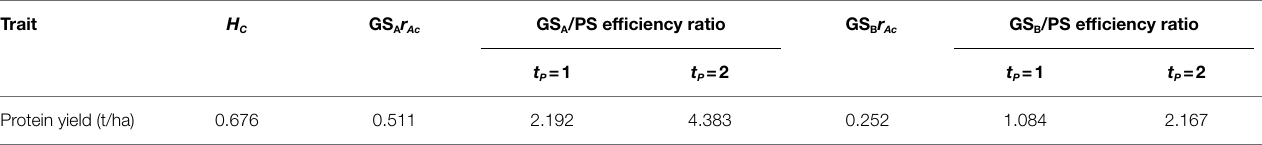
TABLE 9 | Ratio of genomic selection (GS) to phenotypic selection (PS) efficiency for protein yield based on predicted genetic gains per unit time for similar evaluation costs assuming two environments for PS and for generation of phenotyping data for intra-population and inter-population GS scenarios.